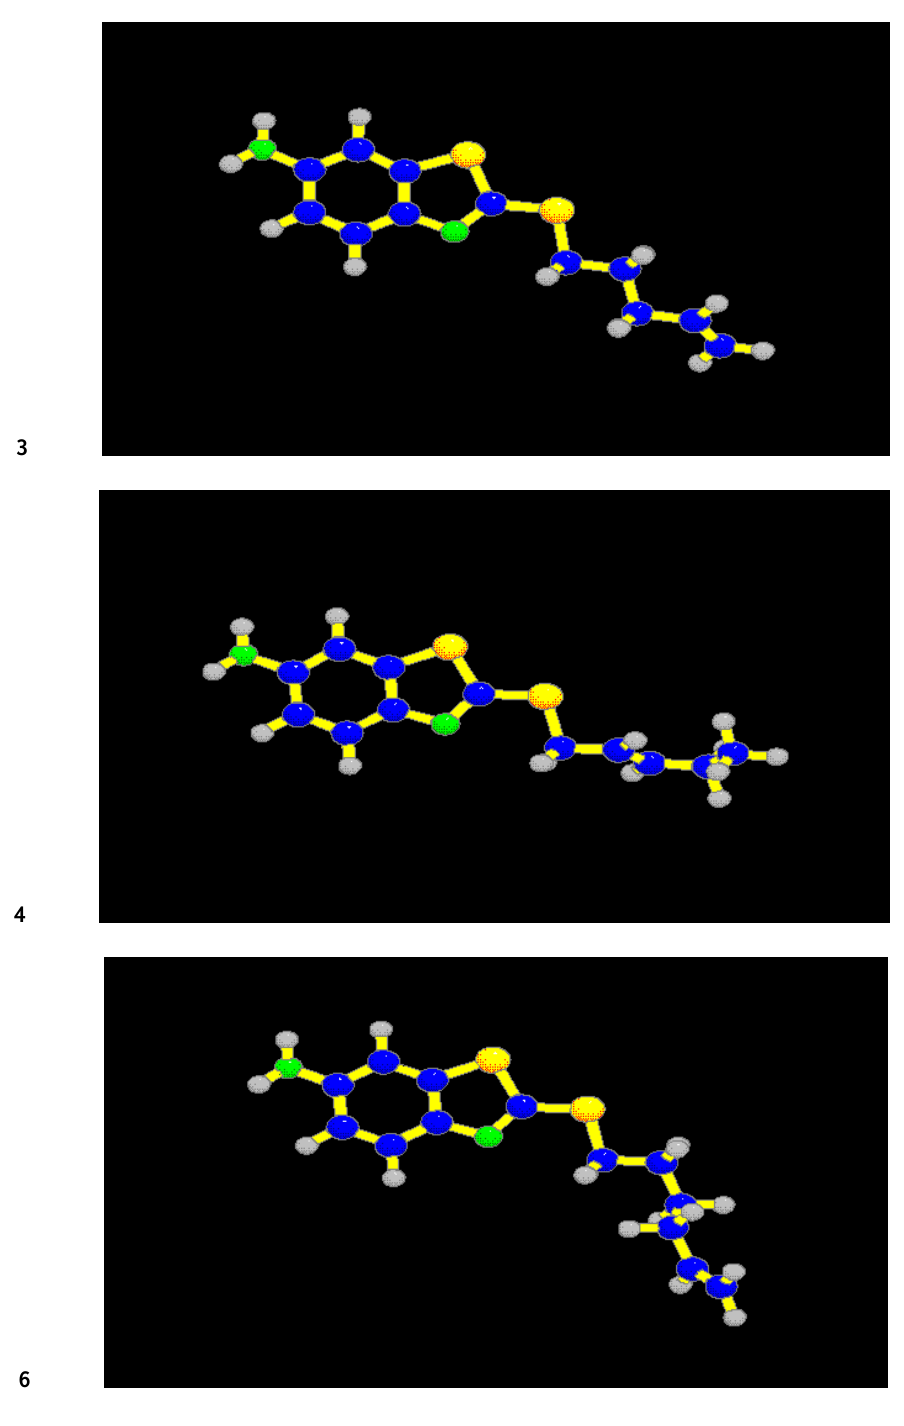
Figure 2. Structures of the compounds with the best antimicrobial activities. (Sulfur atoms are yellow, nitrogen atoms are